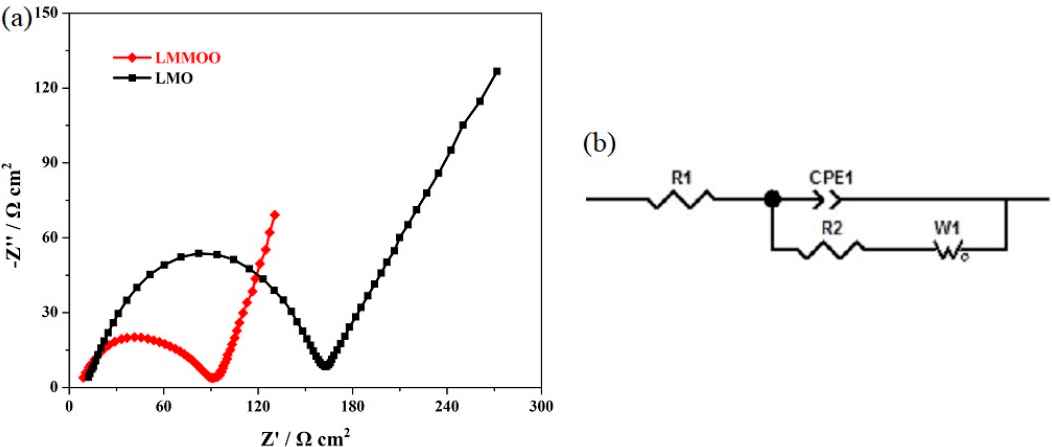
Figure 8. ( a ) Nyquist plots of the LiMn 2 O 4 and octahedral LiMn 1.95 Mg 0.05 O 4 samples and ( b ) equivalent circuit model of EIS.